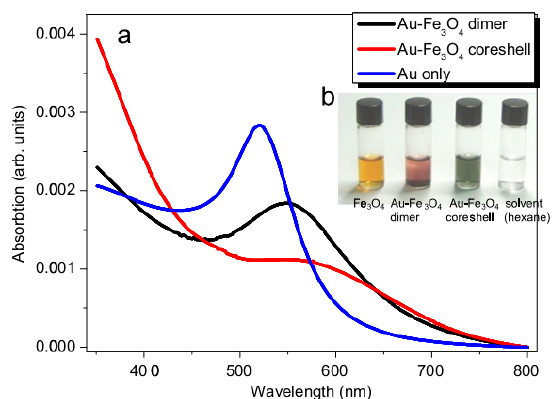
Figure 19. ( a ) Optical absorption spectra of ~8 nm sized Au, Au-Fe 3 O 4 dimer and core-shell nanoparticles; and ( b ) image of Fe 3 O 4 and Au-Fe 3 O 4 NPs suspensions in hexane. Reproduced with permission from [70]. Elsevier, 2012.